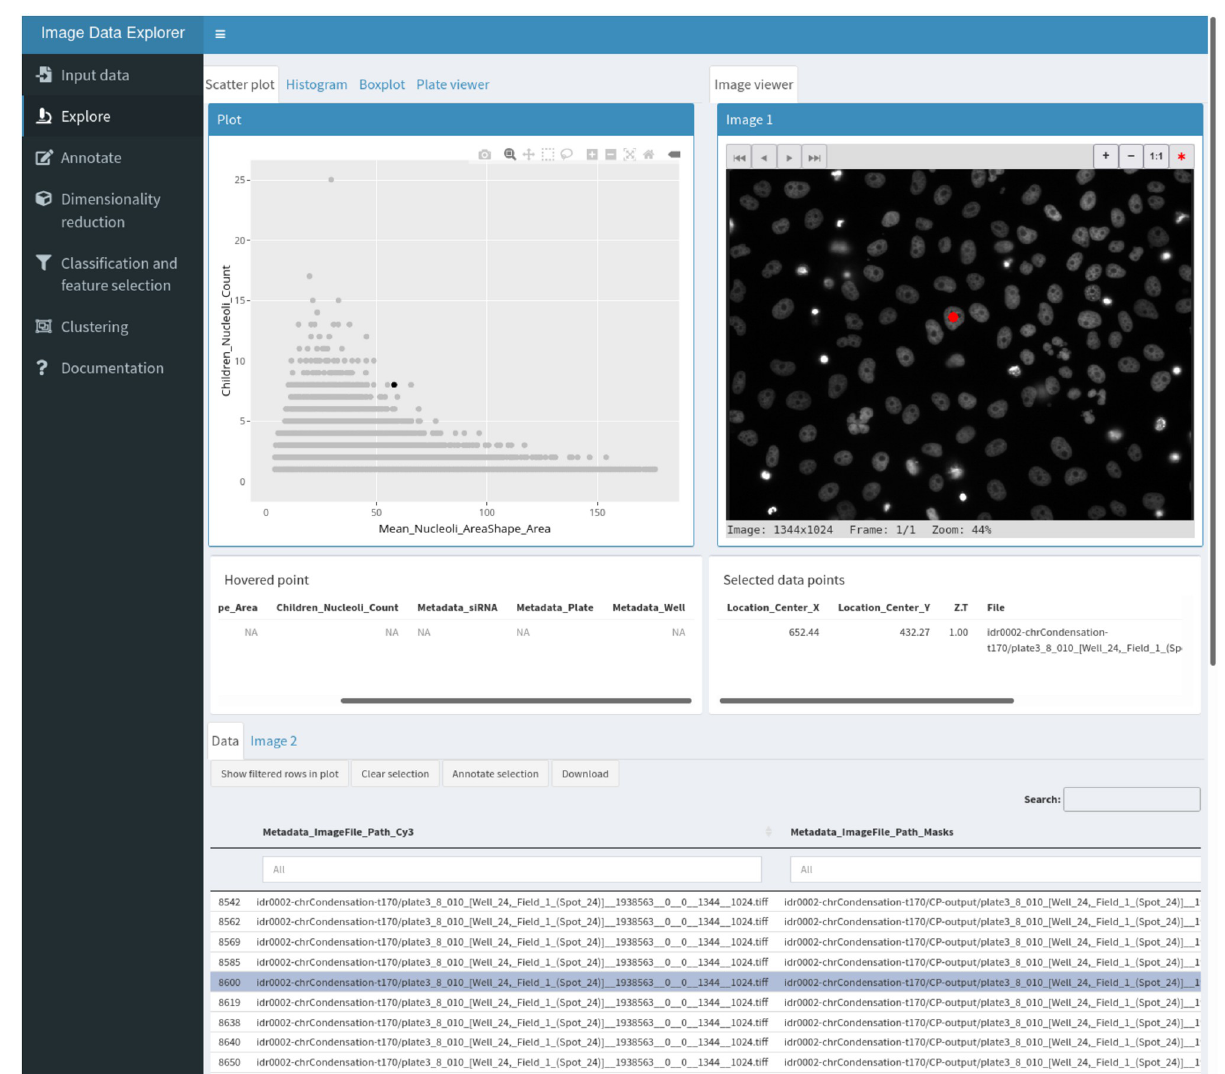
Fig 1. The explore workspace. The top left panel is used for plotting, the top right panel is an interactive image viewer and the bottom section shows the interactive data table with a tab to access a second image viewer. The red dot in the image viewer indicate the position of the segmented object corresponding to the selected data point shown in black in the scatter plot and highlighted in the data